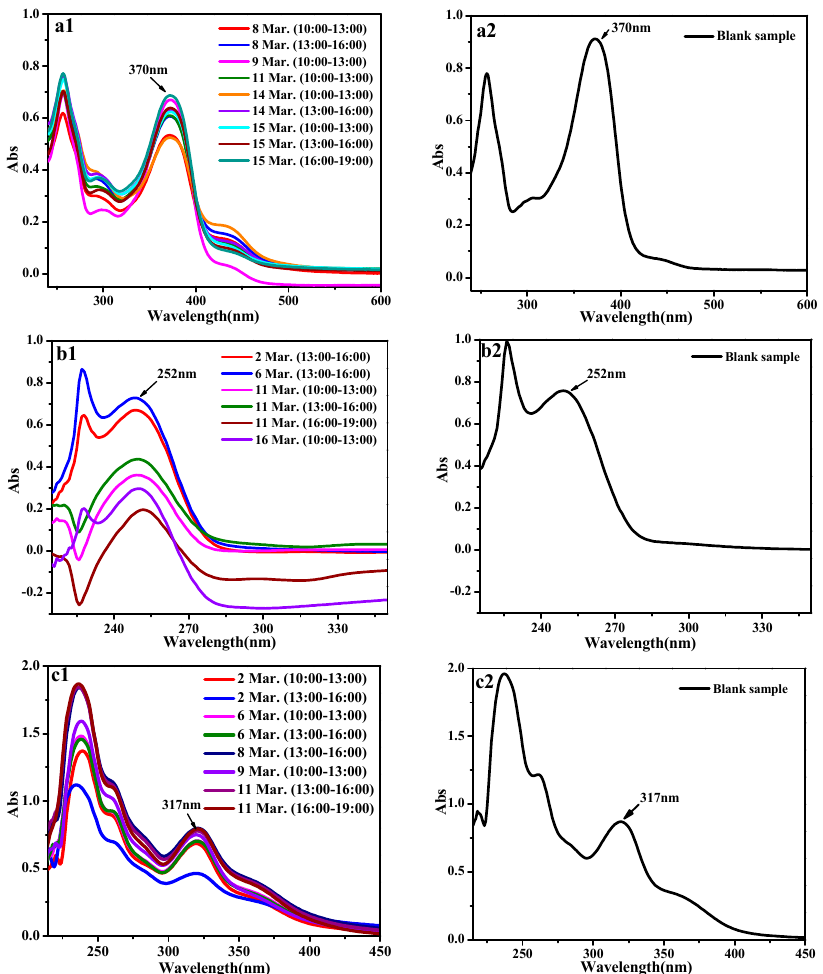
Figure 7. ( a ) UV curves for quercetin after and before sampling; ( b ) UV curves for glycyrrhizic after and before sampling; ( c ) UV curves for α -mangostin after and before sampling. Table 7. The RSD for three active molecules with di ff erent methods. Active Molecule RSD%